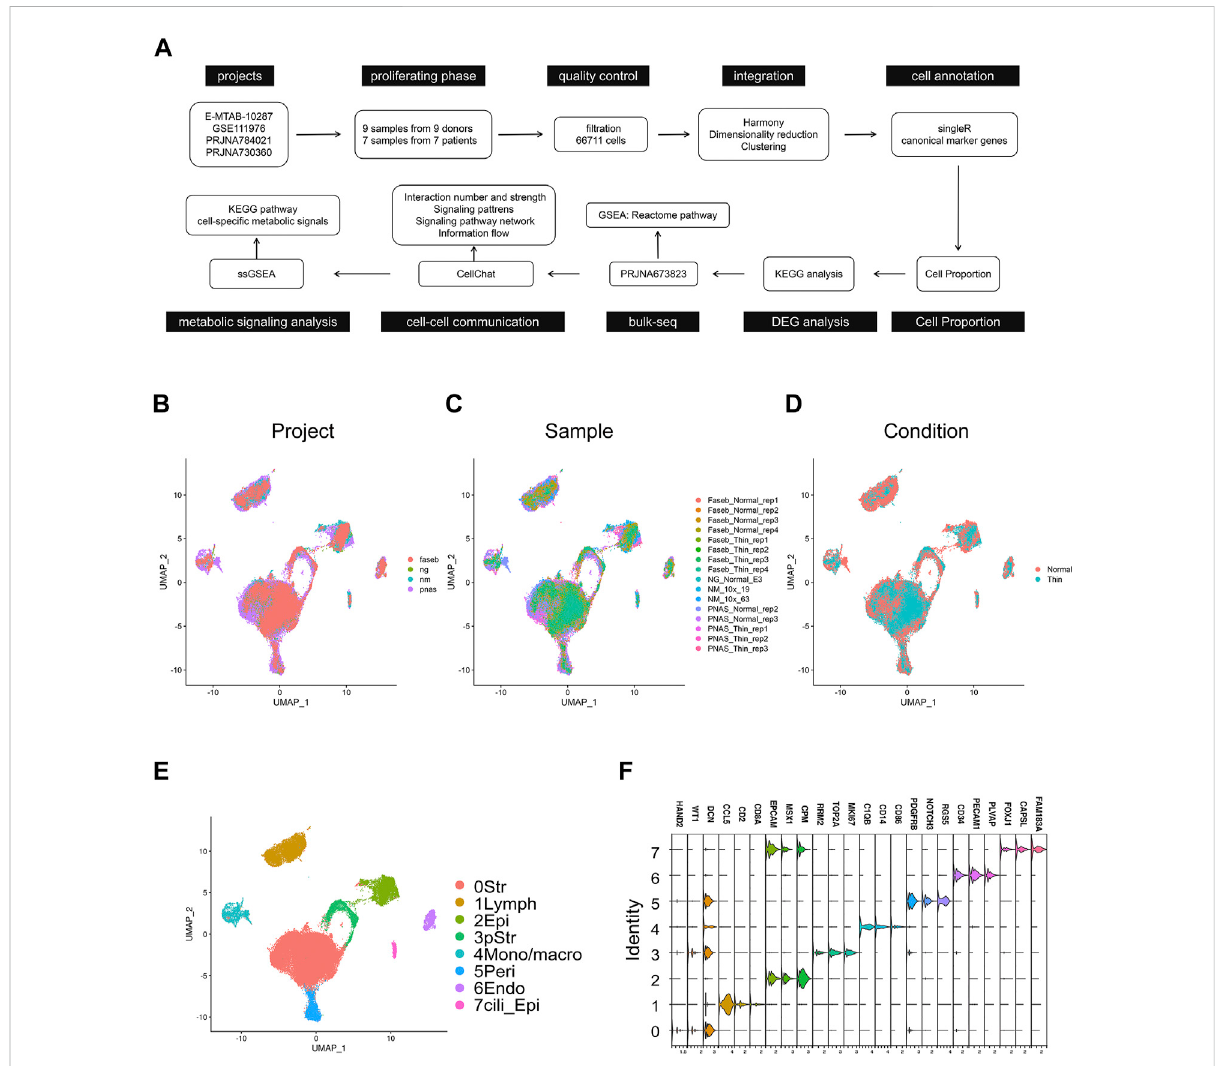
FIGURE 1 Integration of scRNA-seq projects for human normal endometrial tissue and thin endometrial tissue. (A) Work fl ow of scRNA-seq and bulk-seq data processing and analyzing for thin endometrial tissue. UMAP visualization showing the integrated effects of 66,711 cells in projects (B) , samples (C) , and conditions. (D) . (E) UMAP of cells demonstrating 8 major cell types. Str, stromal cell; Lymph, lymphoid cells; Epi, epithelial cells; pStr, proliferating stromal cells; Mono/macro, mono/macrophages; Peri, pericytes; Endo, endothelial cells; and Cili_Epi, ciliated epithelial cells. (F) Violin plot showing the expression level of the marker genes in each cell